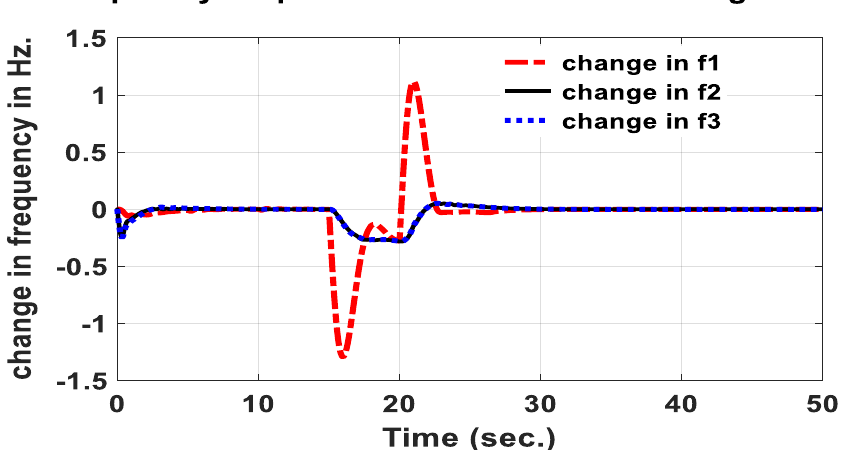
Figure 20. Frequency response of f1, f2 and f3 due to random load change.